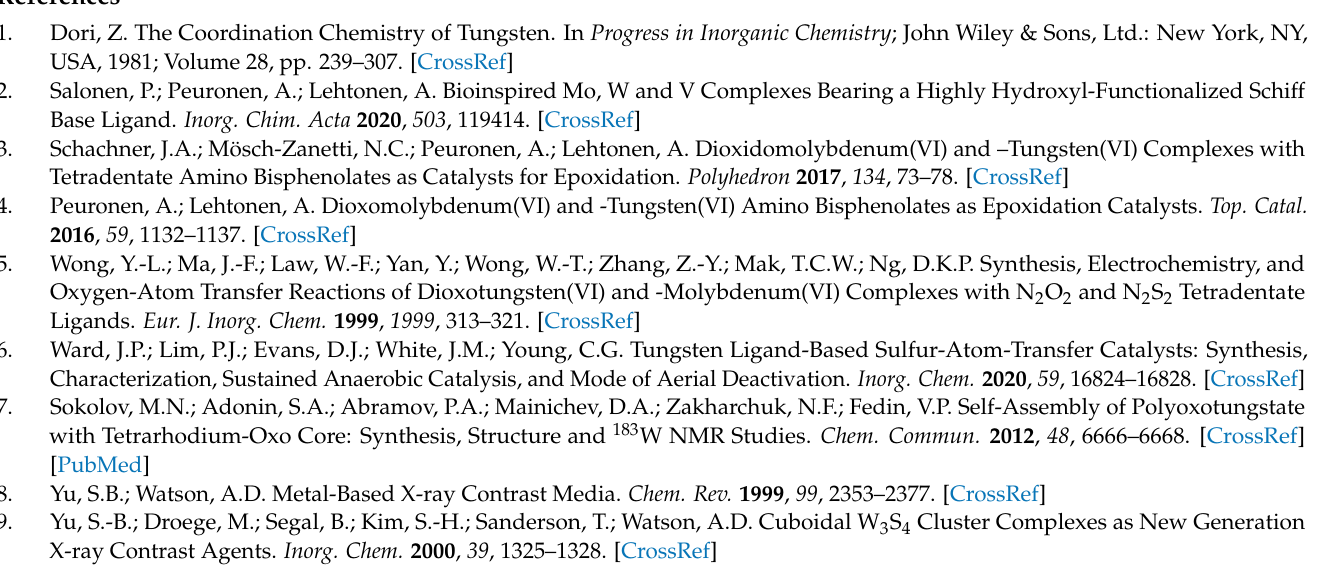
determination; Figure S10: Stereoscopic ORTEP plot of the asymmetric unit of 2a showing the atomic numbering scheme.; Figure S11: Stereoscopic ORTEP plot of 3 showing the atomic numbering scheme.; Figure S12: Stereoscopic ORTEP plot of complex 4 and the two DMSO molecules of the asymmetric unit showing the atomic numbering scheme.; Figure S13: Stereoscopic ORTEP plot of complex 5 showing the atomic numbering scheme.; Table S1: Crystallographic data and structure refinement for complexes 2a and 3 ; Table S2: Crystallographic data and structure refinement for complexes 4 and 5 ; Table S3: Selected bond lengths [Å] and angles [ ◦ ] for 2a ; Table S4: Hydrogen bonds for 2a [Å, ◦ ]; Table S5: Selected bond lengths [Å] and angles [ ◦ ] for 3 ; Table S6: Hydrogen bonds for 3 [Å, ◦ ]; Table S7: Selected bond lengths [Å] and angles [ ◦ ] for 4 ; Table S8: Hydrogen bonds for 4 [Å, ◦ ]; Table S9: Selected bond lengths [Å] and angles [ ◦ ] for 5 ; Table S10: Hydrogen bonds for 5 [Å, ◦ ]; Figure S14: Stability of complex 3 in DMSO-d 6 ; Figure S15. Stability of complex 3 dissolved in phosphate buffer (pH 7.4) as followed by UV-Vis